Question: What caption would you write for this figure?
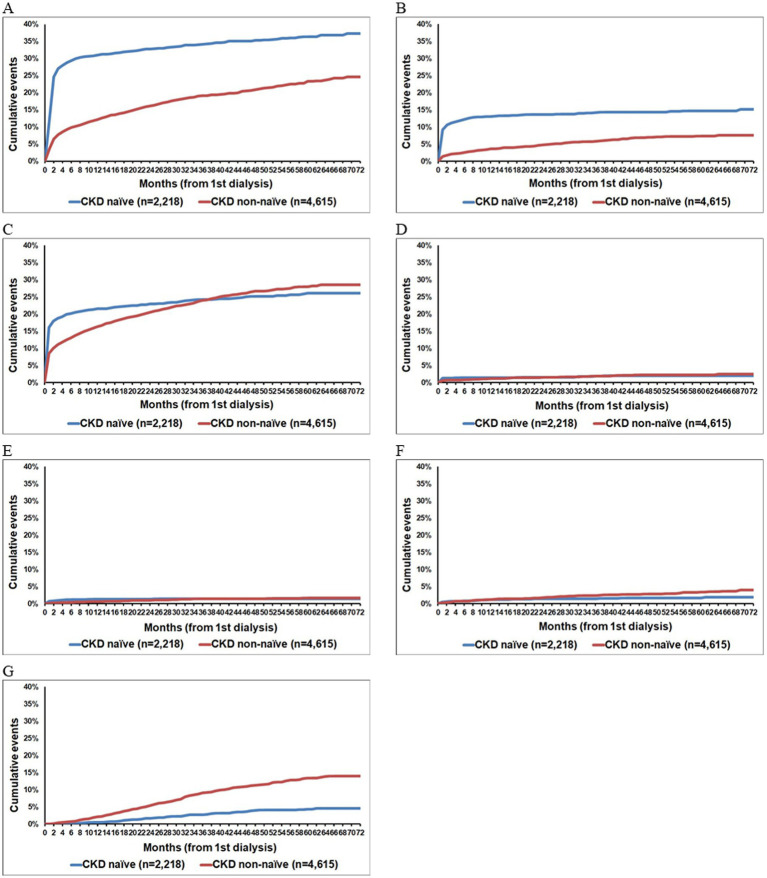
Answer: Cumulative incidence of the primary endpoints from the time-to-first event analyses in the CKD naive arm ( n = 2,218) and the CKD non-naive arm ( n = 4,615) during the 72-month follow-up after the first dialysis. Primary endpoints were (A) all-cause mortality, (B) cancer, (C) hospitalization for heart failure, (D) acute myocardial infarction with percutaneous coronary intervention, (E) stroke (with CT/MR), (F) lower limb amputation, and (G) kidney transplantation. Data are unadjusted for the different propensity score subclassification hazards (no differences in hazards and statistics provided).